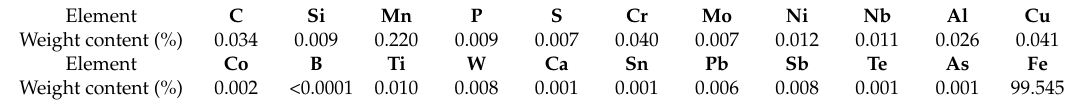
Table 1. The detailed chemical composition of the low-alloy steel.